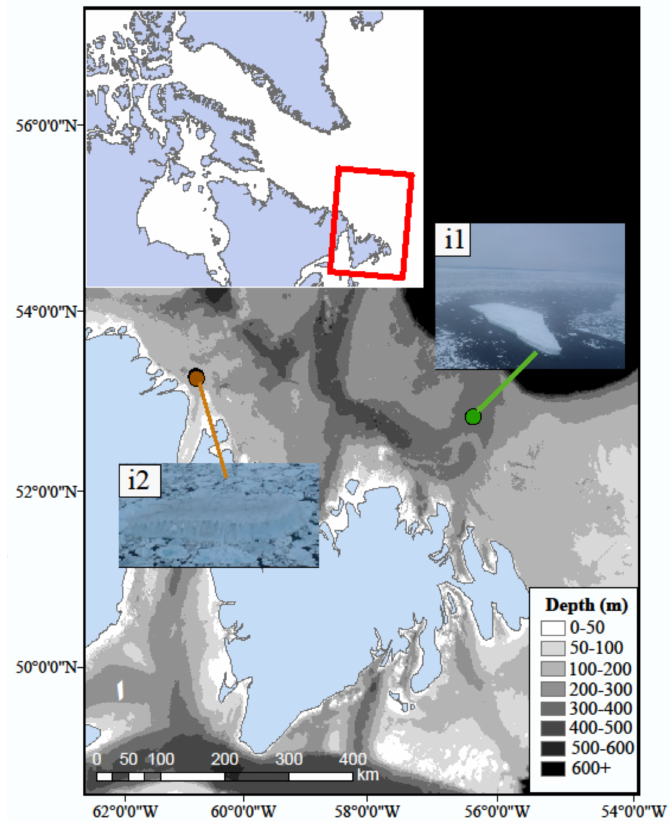
Figure 1. Location and images of the surveyed icebergs, i1 and i2. Bathymetry data was obtained from the 2-min Gridded Global Relief Data—ETOPOv2